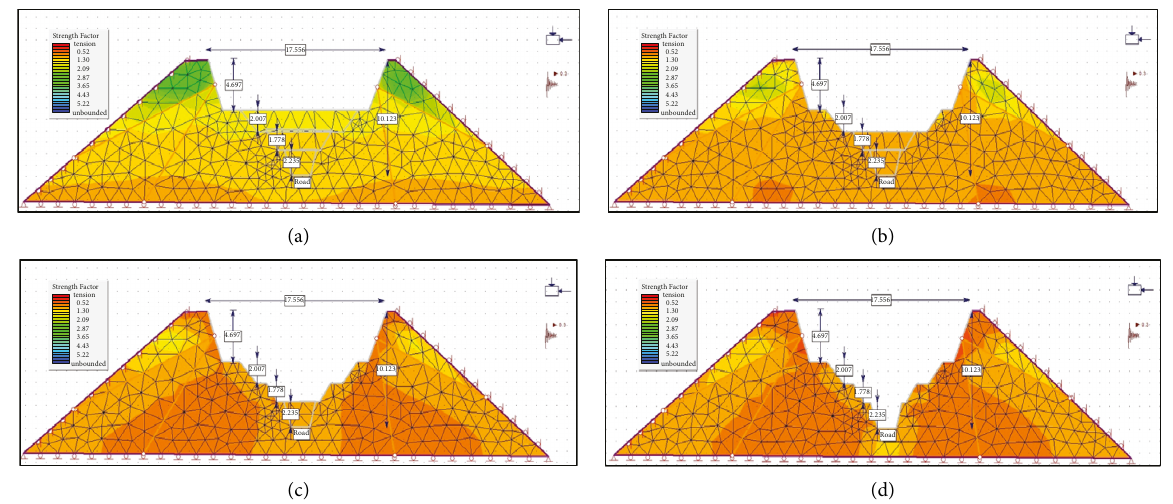
Figure 7: Strength factor simulated at (a) stage 1, (b) stage 2, (c) stage 3, and (d) stage 4 of road